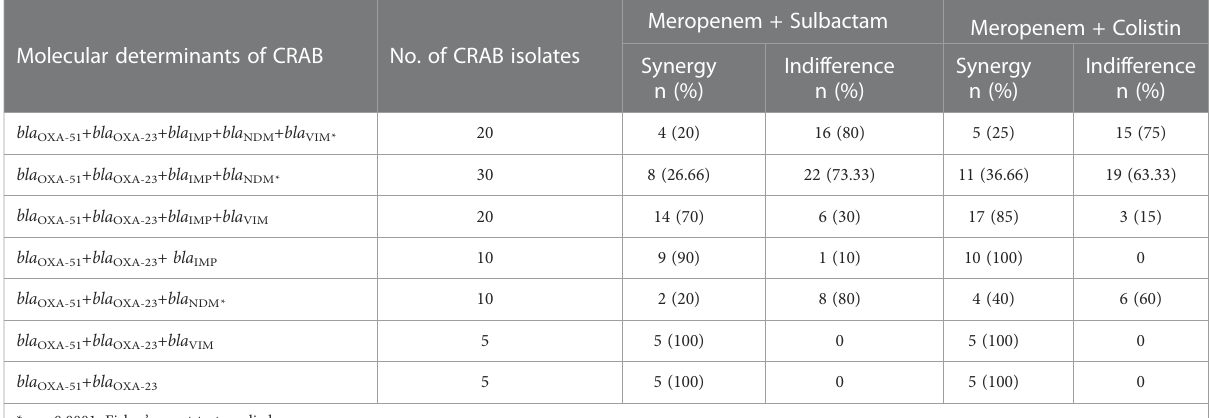
TABLE 5 Comparison of drug synergy and molecular determinants of CRAB isolates.